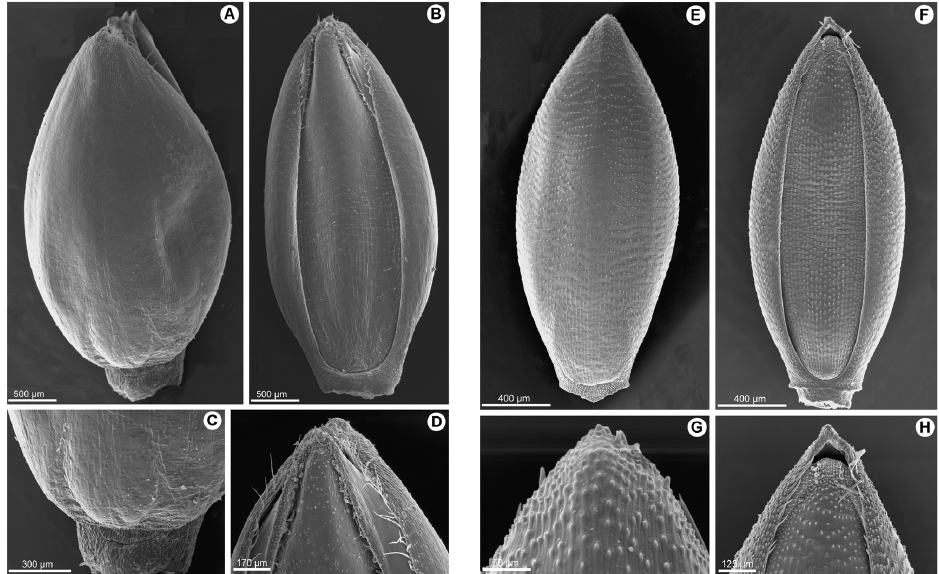
Figure 3. ( A–D ). Scanning electron micrographs of the upper anthecium of Panicum deustum : ( A ). dorsal view; ( B ). ventral view; ( C ). base of the upper lemma; and ( D ). apex of the upper palea. ( E– H ). Scanning electron micrographs of the upper anthecium of Panicum trichocladum : ( E ). dorsal view; ( F ). ventral view; ( G ). apex of the upper lemma; and ( H ). apex of the upper palea [vouchers: ( A – D